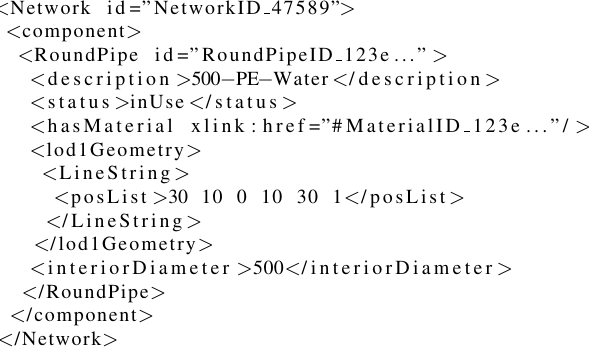
Figure 4. Example of linkage between a RoundPipe object and its material by means of an XLink containing the ID (gml:id) of the material object.